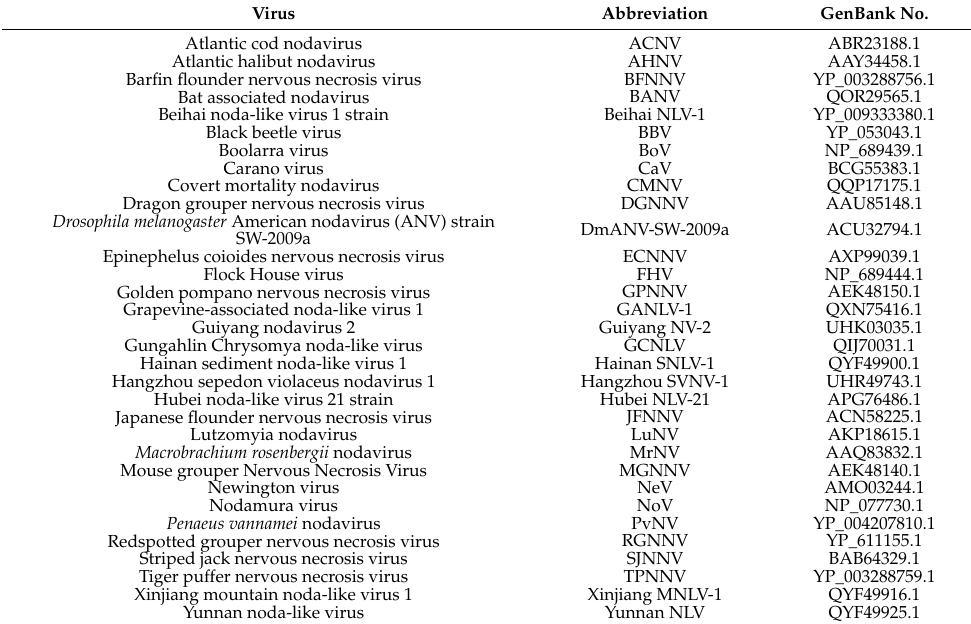
Table 1. Names and abbreviations of Nodaviridae species used in phylogenetic